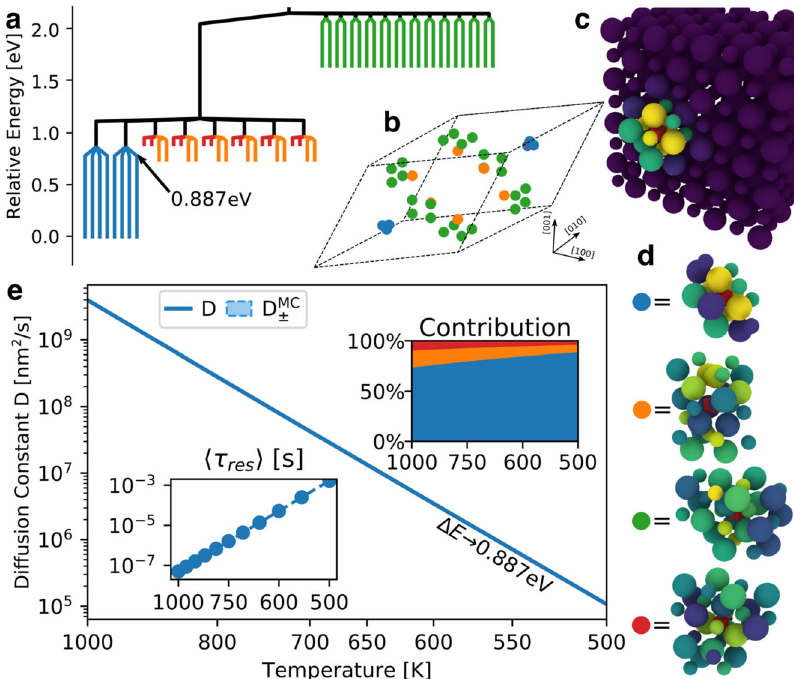
Fig. 2 Sampling of Hexa-interstitial in MgO. a Connectivity graph 23 between states irreducible under translation. The very low diffusion barriers (<0.1 eV) observed in previous work 7,8 can be seen. b Nonequivalent positions in the primitive unit cell for the four irreducible states. c Cross-section of the lowest energy state. Atoms colored by centrosymmetry 51 . d Atomic structure of the four lowest energy irreducible states. e Single eigenvalue of the diffusion tensor at various temperatures. Error bounds, calculated through the Monte Carlo procedure detailed in the main text, are not visible on the presented scale. Insets show 〈 τ res 〉 at various temperatures and the contribution to the overall diffusivity from self transitions within each state. The fast diffusing states have increasing contribution at high temperatures as they are occupied more